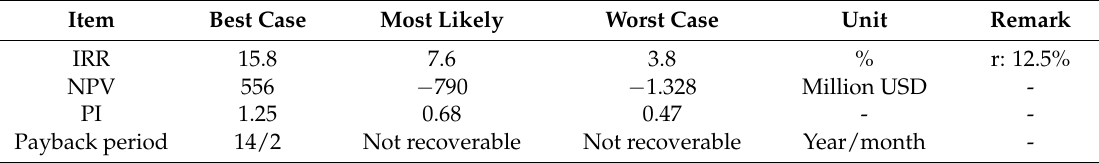
Table 10. Project A project company model economic evaluation. NPV: net present